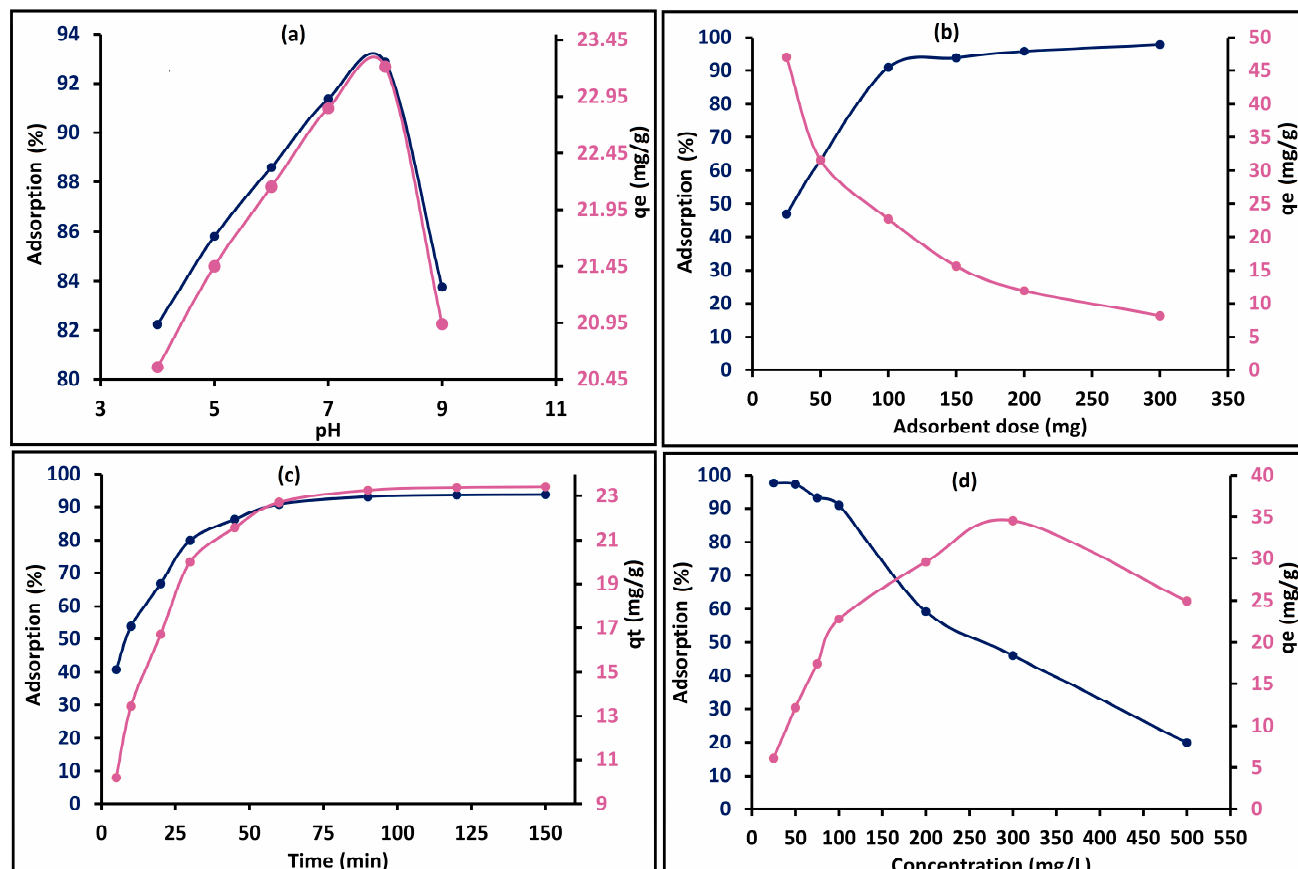
Figure 6. ( a ) Effect of pH, ( b ) effect of adsorbent dose, ( c ) effect of adsorption time, and ( d ) effect of concentration on adsorption of R-16dye ( Blue= Adsorption % and Pink = q e ).